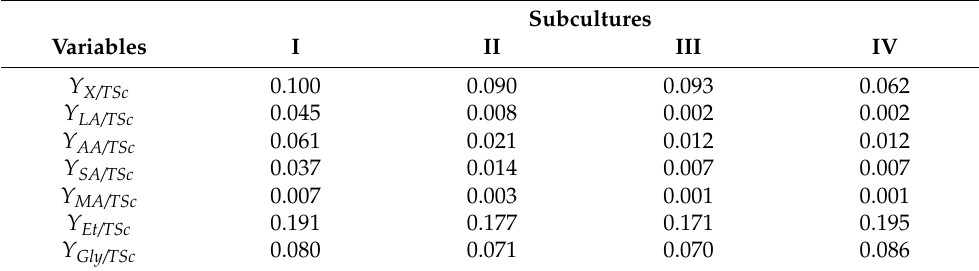
Table 3. Fermentation Yields Calculated at the End of Every Subculture in Fed-Batch